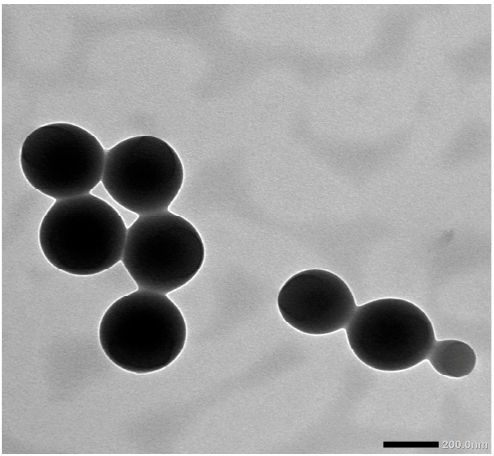
Figure 1. Transmission electron microscopy image of CAPE-PEG–PLGA NPs showing their particle size.